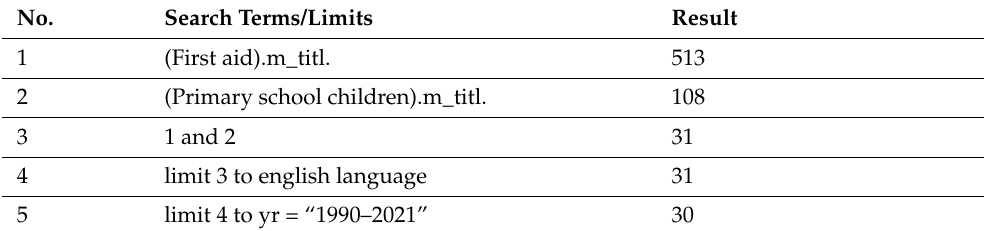
Table A2. Cochrane library search 3 January